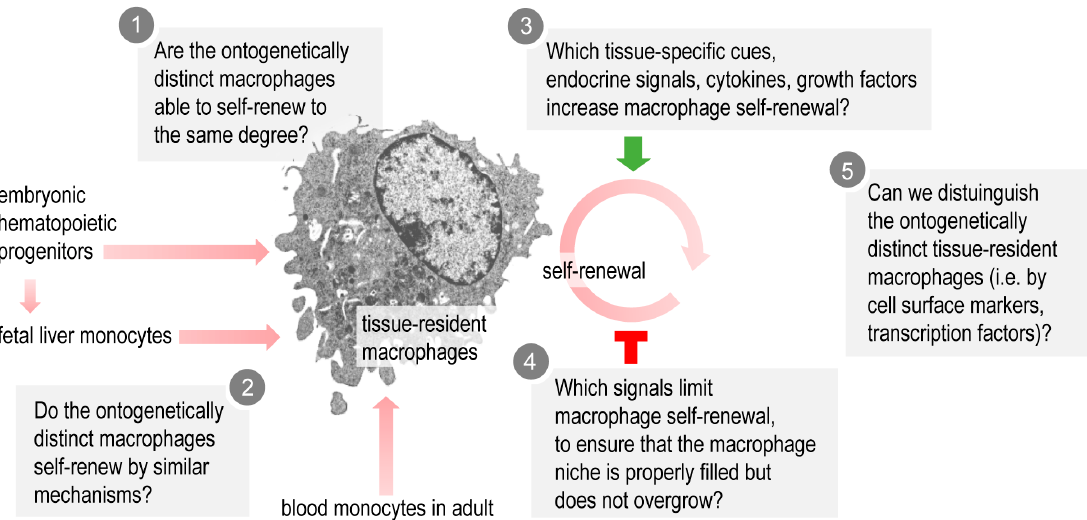
Figure 4. Open questions about tissue resident macrophage self-renewal. It is still unknown whether ontogenetically distinct tissue-resident macrophages have similar or distinct self-renew abilities ( 1 ); Answering this question will be important for determining the proportion of macrophages developing from embryonic or adult hematopoietic progenitors. It is not known whether ontogenetically distinct macrophages have their own specific mechanisms that allow self-renewal or induce quiescence ( 2 ); Tissue macrophage pools are stable in the physiological steady state; however, little is known about the signals that allow the build-up and replenishment of the macrophage pool by self-renewal ( 3 ); or limit the expansion of the macrophage niche ( 4 ); We still lack information about possible surface markers or transcription factors that clearly distinguish self-renewing macrophages ( 5 ).